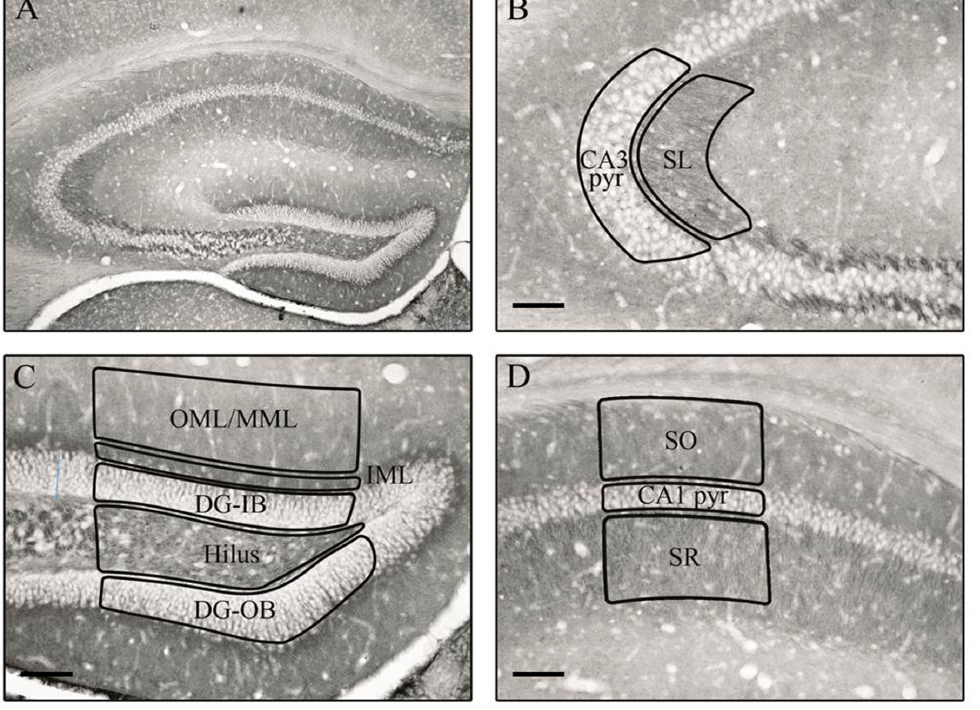
Figure 1. PSD ‐ 95 expression in the C57BL/6 PKU mouse. ( A ) An overview picture of the PSD ‐ 95 immunostaining; The following 10 areas of interest were measured: ( B ) CA3: stratum lucidum (SL), CA3 pyramidal cell layer (CA3 pyr); ( C ) DG: outer and middle molecular layer (OML/MML), the inner molecular layer (IML), inner (DG ‐ IB) and outer blade (DG ‐ OB) of the dentate gyrus, hilus; ( D ) CA1: stratum oriens (SO), CA1 pyramidal cell layer (CA1 pyr) and the stratum radiatum (SR); ( E ) a detailed picture of the granular layers present in the DG; ( F ) a detailed picture of the CA1 pyramidal cell layer. Arrows indicate clear staining within the granular layer. The size bar indicates 100 μ m. The detail pictures within ( E ) and ( F ) are digitally enlarged. 2.4. Statistical Analysis The distribution of all parameters was checked with the Shapiro ‐ Wilk normality test. Normally distributed data were tested with a one ‐ way ANOVA with the Bonferroni test as a post hoc test. The Kruskal ‐ Wallis test was used for non ‐ parametric data with the Mann ‐ Whitney U test as a post hoc test. All statistical analyses were performed with the Statistical Package for Social Sciences (SPSS) (SPSS Inc. SPSS for Windows, Version 16.0. Chicago, IL, USA).